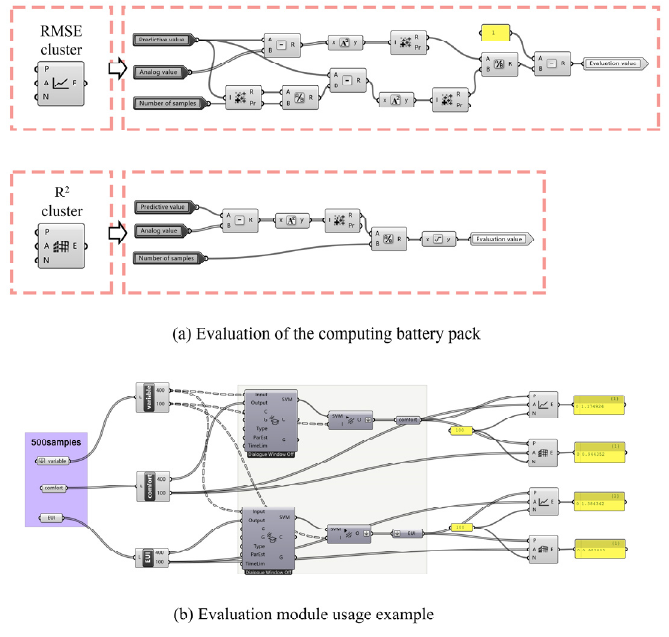
Figure 10. Evaluation of modular battery packs and usage examples.